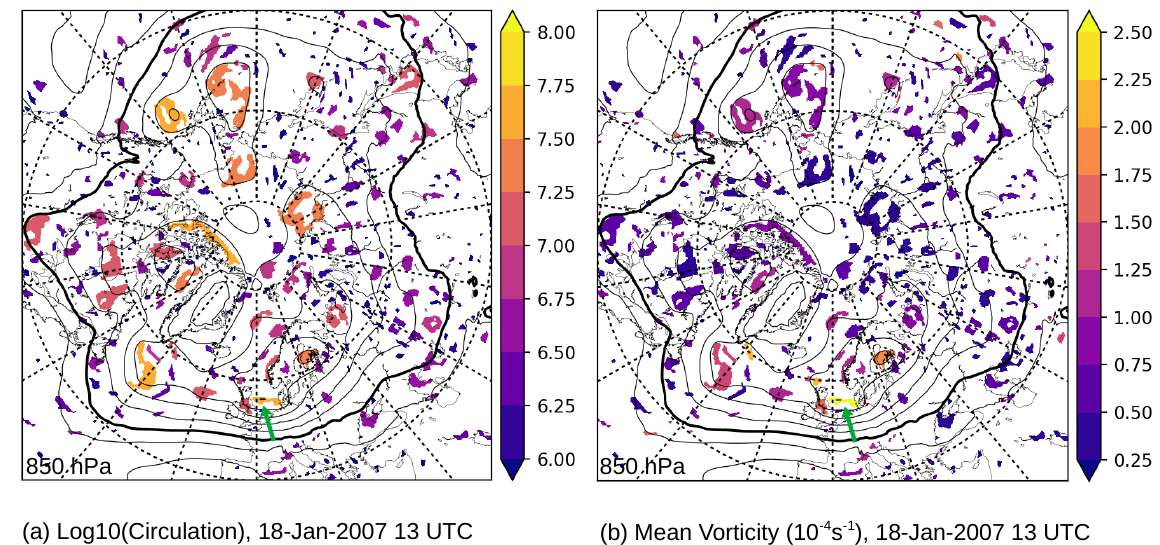
Figure 7. Vortex patches field at 850hPa identified in Climate Forecast System Reanalysis (CFSR) data on 18 January 2007 at 13 UTC color shaded ( a ) by their circulation magnitude (logarithm of circulation, circulation has units of m 2 s − 1 ) and ( b ) by their mean vorticity (in 10 − 4 s − 4 ). Geopotential height given in 80-m intervals as black contours; the thick black contour is the 1440-m geopotential height contour; the approximate location of Kyrill is indicated by the green arrow.